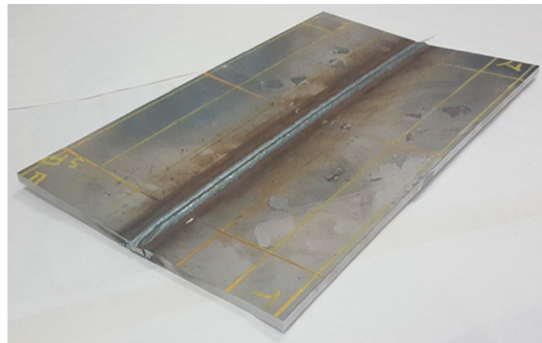
Figure 13. Experiment result of multi-pass butt-joint.